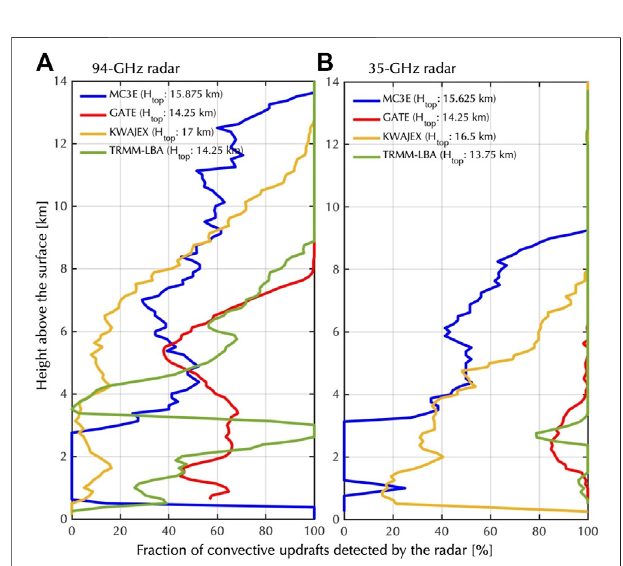
FIGURE 3 | Fraction of convective updraft (V AIR > 2 ms − 1 ) detected by the (A) 94 GHz and (B) 35 GHz radars as a function of height. An estimate of cloud height (H top ) for the various cloud types simulated is given in the legend. Results are shown for the different cloud types under study (colors as in Figure 2